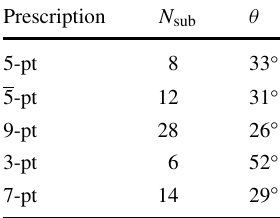
factorization scales by a factor of two in either direction (i.e. described in Sect. 5.1, are shown in Table 3: for each pre-